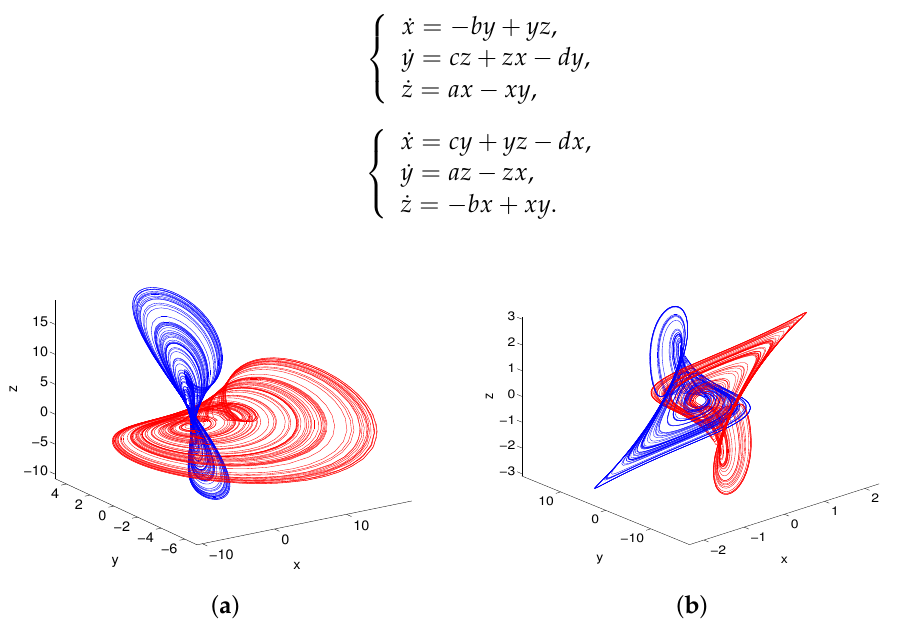
Figure 10. ( a ) The red plot corresponds to system (11), and the blue plot corresponds to system (12), with (a,b,c,d)=(1,22,16,10). ( b ) The red plot corresponds to system (13), and the blue plot corresponds to system (1), with ( a , b , c , d ) = ( 0.4,50,16,10 ) . In addition, if we only revise C = ( 1, − 1, − 1 ) T in system (8), system (13) is chaotic for the same parameters as system (1), when we have the parameters a = 0.4, b = 50, c =